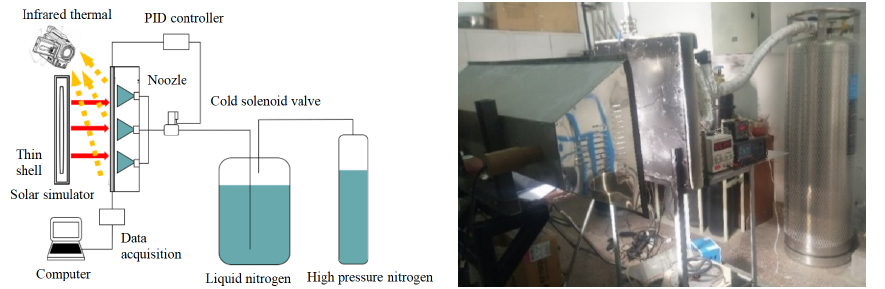
Figure 1. Schematic diagram of the experimental system under the heating mode of quartz lamp (low heat flux) and experimental bench.